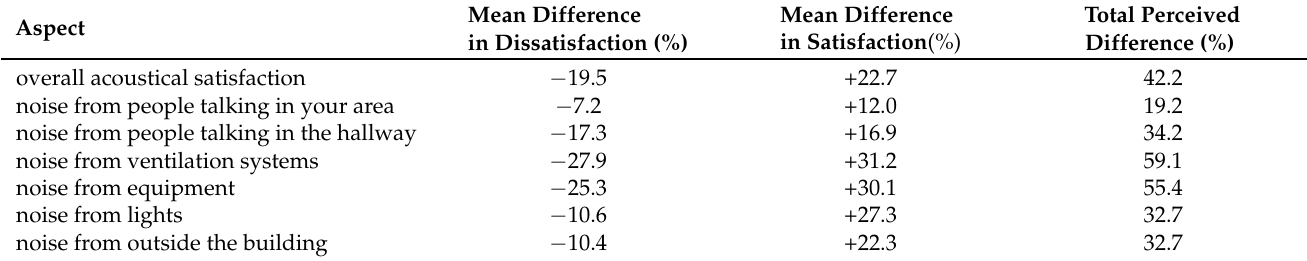
Table 2. Differences in perceived satisfaction of acoustic comfort attributes inside the LEED-certified building as compared with the traditional